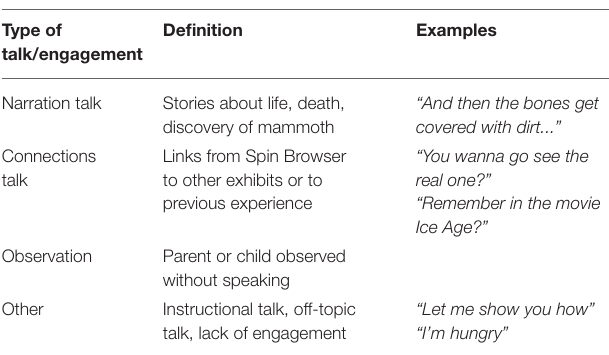
TABLE 1 | Coding categories for parents’ and children’s talk and engagement at the spin browser exhibit (coded in 10s segments).